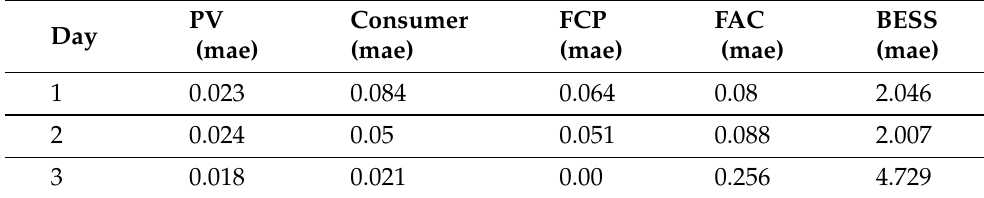
Table 9. Generalised training evaluation with benchmark solutions from the linear